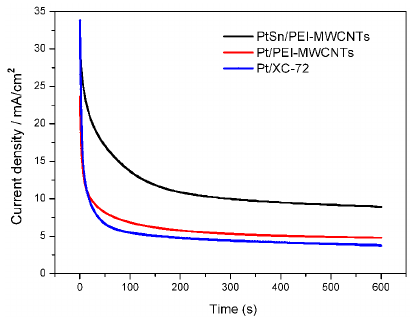
Figure 9. Chronoamperograms recorded at 0.6 v vs. Ag/AgCl for ethanol oxidation on Pt/XC72, Pt/PEI ‐ MWCNTs and PtSn/PEI ‐ MWCNTs catalysts in 0.5 M H 2 SO 4 + 1 M C 2 H 5 OH.